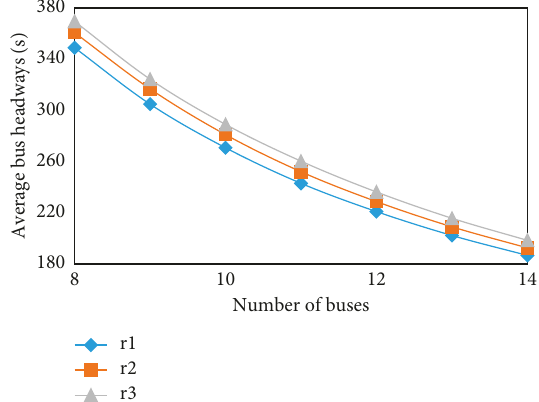
Figure 7: Average bus headways with increasing buses on the